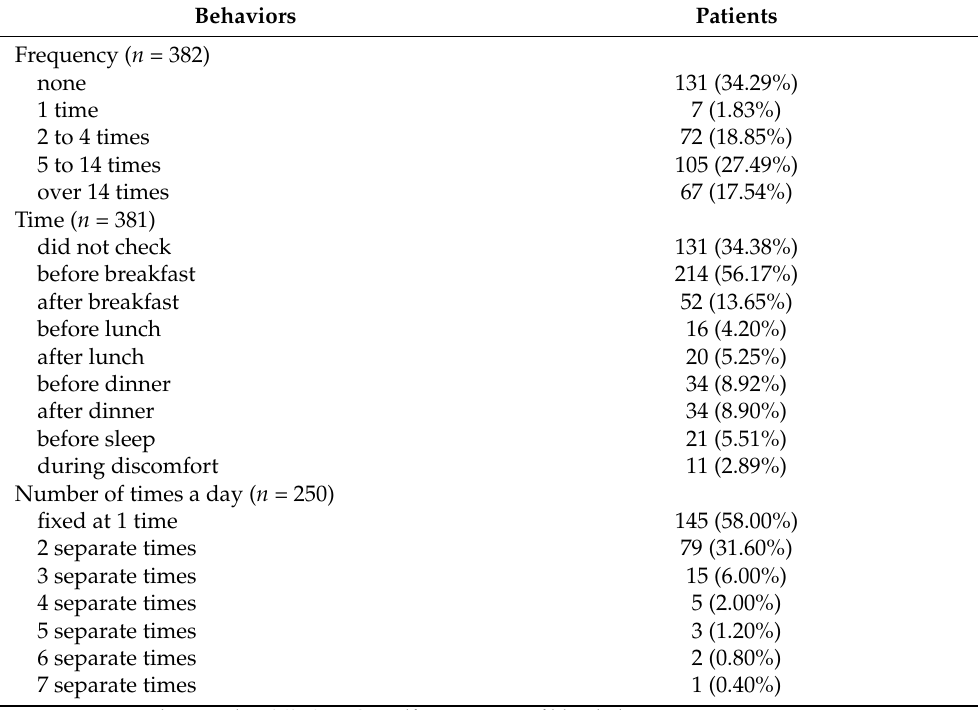
Table 2. Frequency and time of SMBG in the past 1 month.